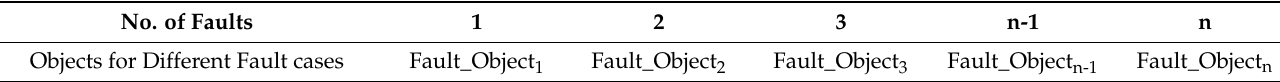
Table 10. Offline library of fault cases.